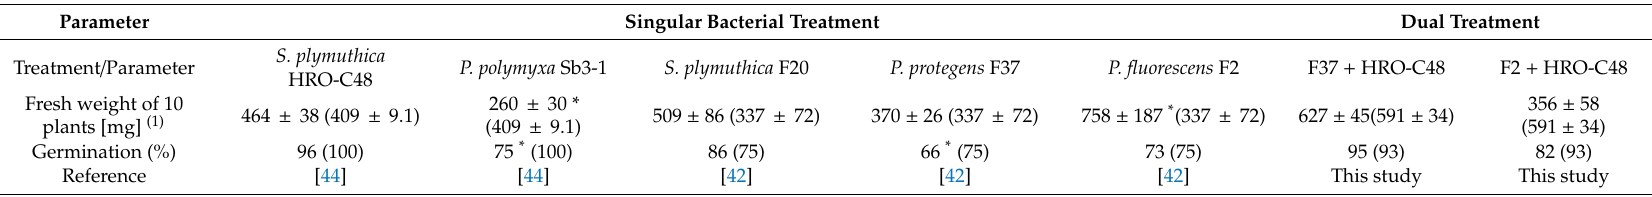
Table 1. E ff ect of the preselected bacterial strains and combinations thereof on the two weeks old oilseed rape seedlings grown under sterile soil-free